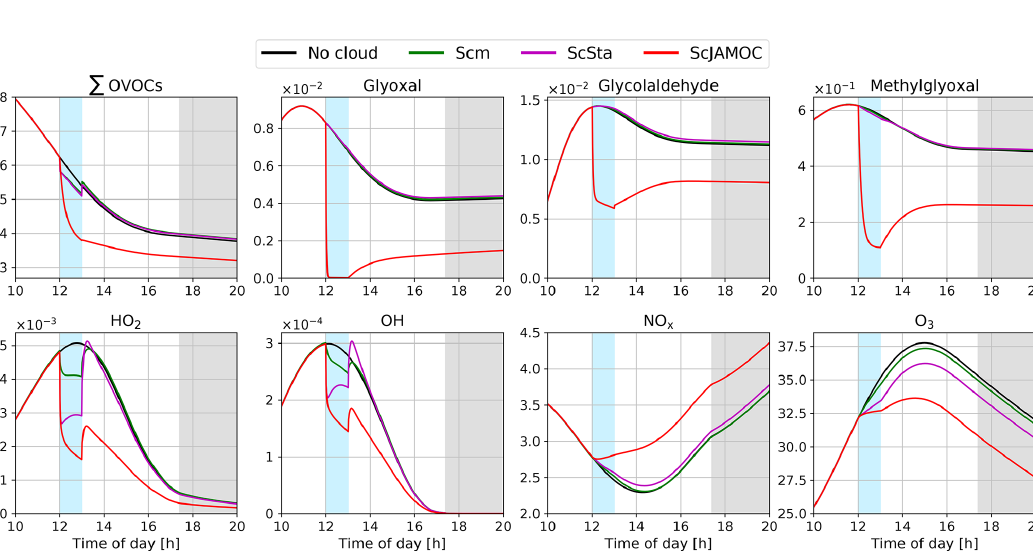
Figure 2. Time evolution for gas-phase mixing ratios of the sum of all the OVOCs explicitly reacting in JAMOC ( (cid:80) OVOCs; see Eq. A1 in Appendix A), glyoxal, glycolaldehyde, methylglyoxal, HO 2 , OH, NO x , and O 3 within the box model CAABA. The time when the cloud is present (between 12:00 and 13:00UTC) is indicated by blue background shading. Nighttime is indicated by grey background shading. Mixing ratios are provided for no-cloud event (black line), Scm (green line), ScSta (purple line), and ScJAMOC (red line). The characteristics of each simulation are provided in Table 1. Note that lines may